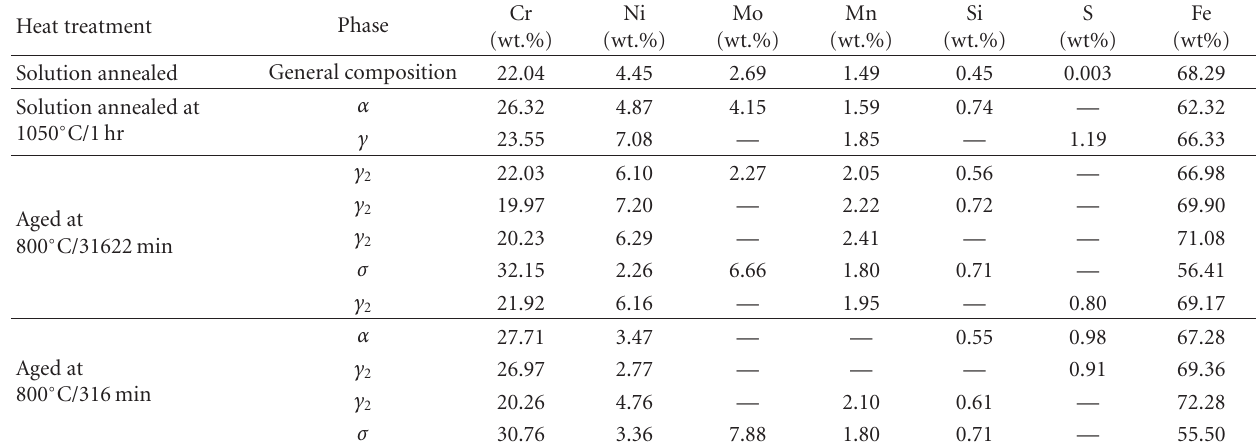
Table 4: EDS analysis of phases present in solution annealed and aged condition of DSS.